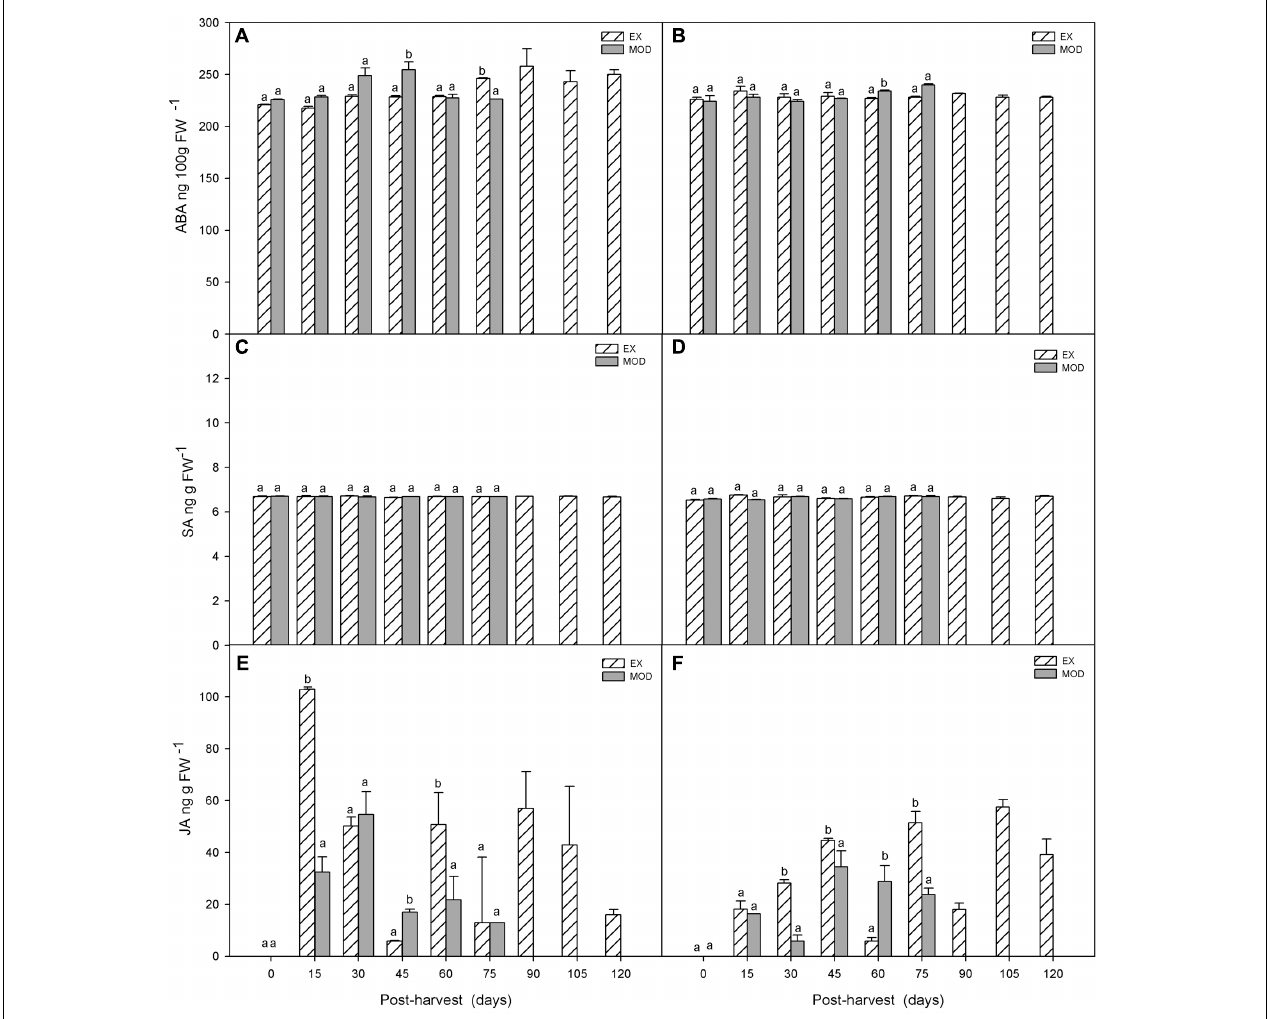
FIGURE 5 | ABA (A,B) , SA (C,D) and JA (E,F) concentrations in apple skin during low temperature storage (0 ◦ C, > 90%RH) of exposed (EX) and moderate sun-damaged (MOD) fruit from orchards Quilpue (A,C,E) and Los Lirios (B,D,F) , Maule Region, Chile. Different lower-case letters indicate statistical difference ( P ≤ 0.05) between sun damage levels at each time point. Values represent means ± SE of 3 biological replicates. MOD fruit was available until 75 days into cold